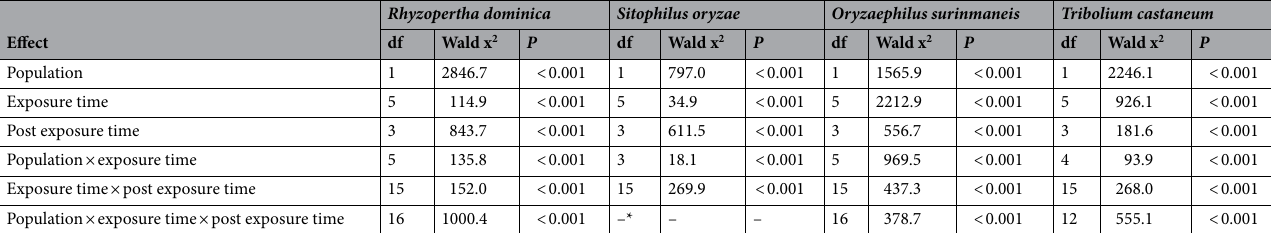
Table 1. Generalized linear model at 3000 ppm of phosphine, showing the effects of the exposure time and the post exposure time, for each population and species. *Interactions could not be estimated.